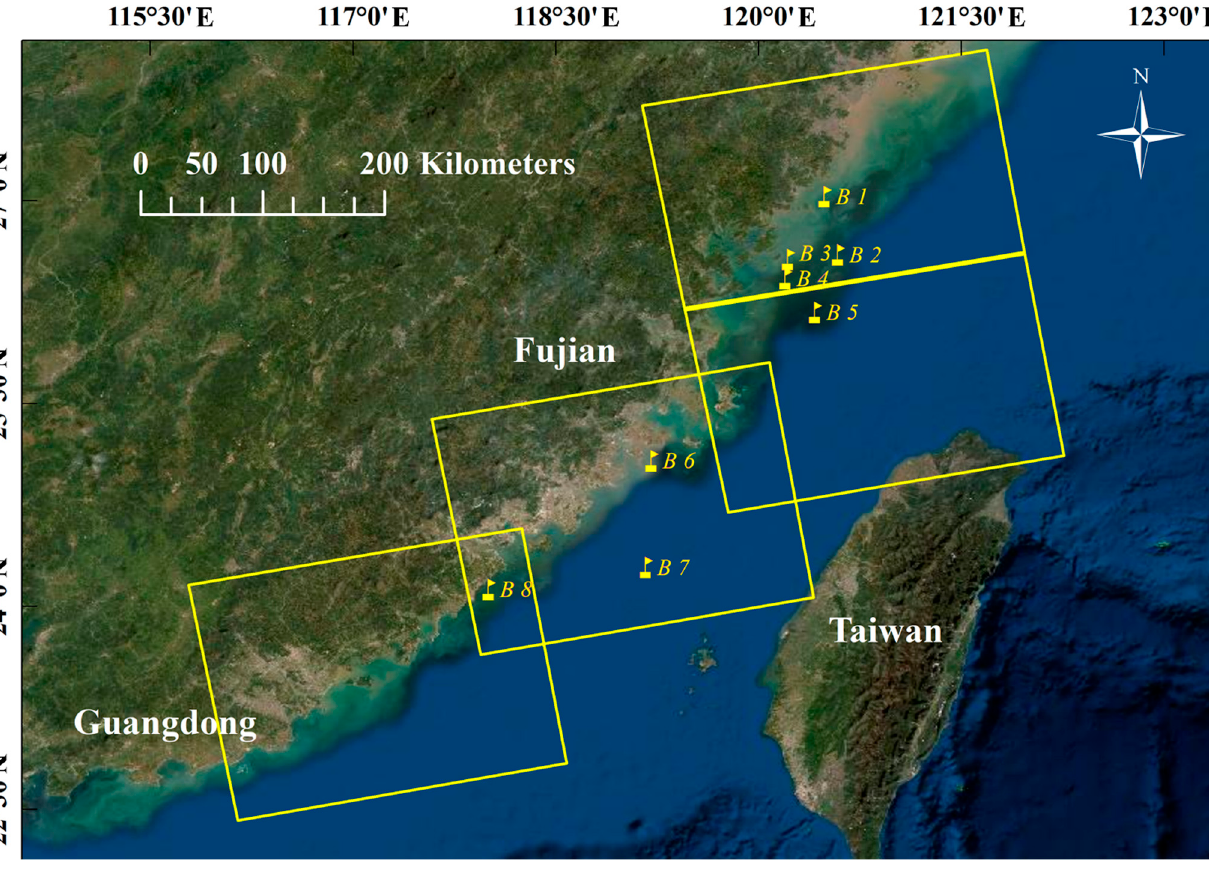
Figure 2. Locations of the coastal buoys for the validation of SAR winds using the proposed model. The yellow rectangular box shows the locations of collocated SAR scenes, and the yellow marks indicate the locations of buoy data. Table 1. The information of buoy data used in this research.